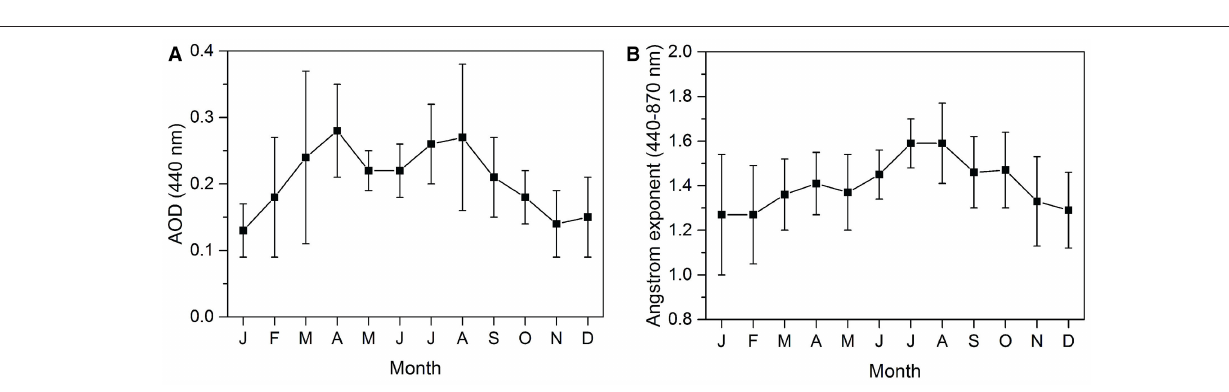
Frontiers in Environmental Science |